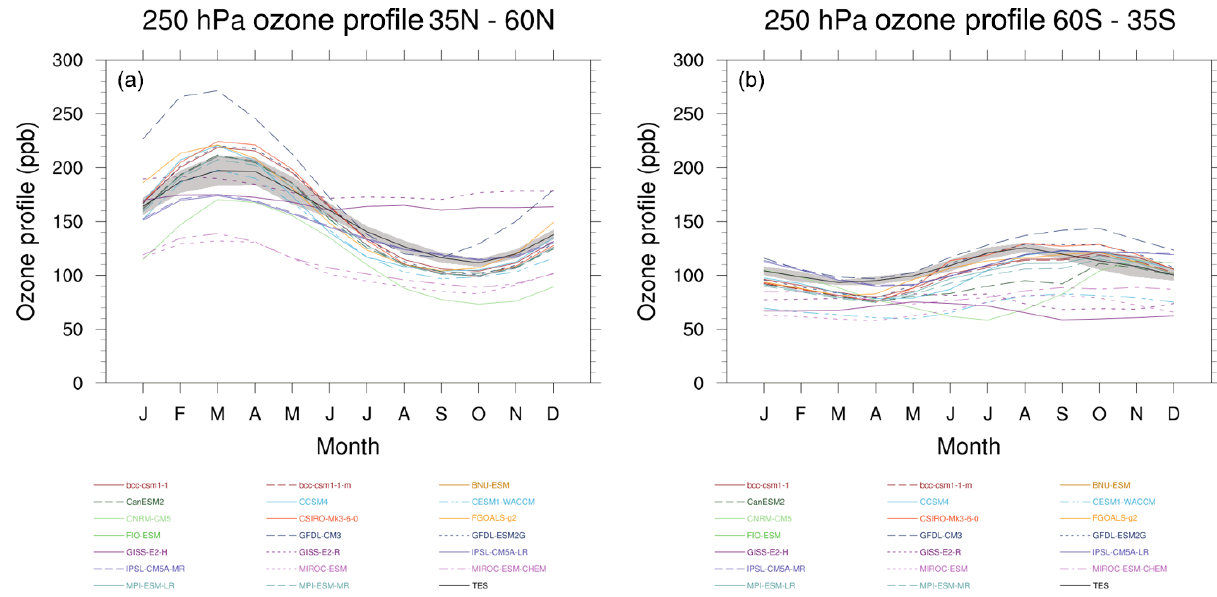
Figure 4. An illustration of a model–observation comparison using obs4MIPs datasets. Tropospheric ozone annual cycle calculated from CMIP5 rcp4.5 simulations and AURA-TES observations, averaged over the years 2006–2009, for the NH (a) and SH (b) mid-latitudes (35– 60 ◦ ) at 250hPa. The individual model simulations are represented by the different colored lines while AURA-TES is shown as the black line (with ± 1 σ shown in